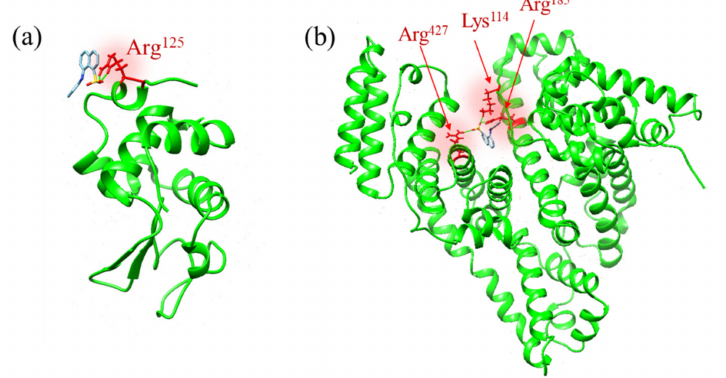
Figure 3. Estimated ANS binding sites of ( a ) lysozyme and ( b ) BSA, which has the lowest ∆ G among the various binding sites. ( a ) The binding site of lysozyme is located at Arg 125 on the protein surface, and ( b ) the binding site of BSA is located inside the hydrophobic pocket with three hydrogen bonds with Lys 114 , Arg 185 , and Arg 427